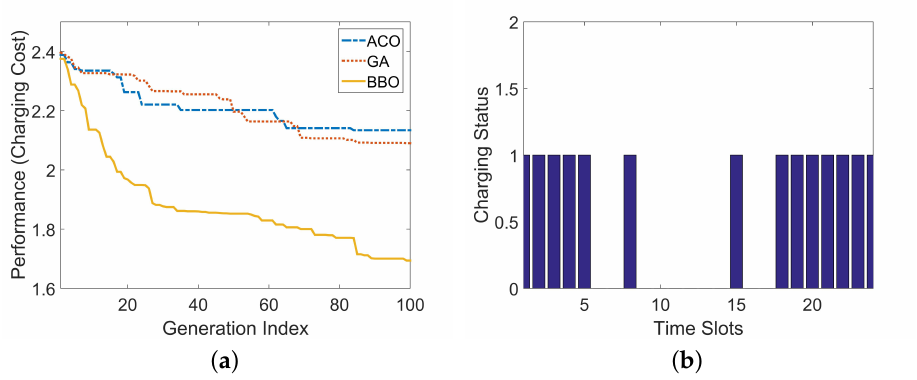
Figure 8. A charging schedule during 0:00–1:00 a.m. by heuristic algorithms. ( a ) Performance (charging cost) comparison for ACO, GA, and BBO in a single time slot and ( b ) a charging schedule by BBO at the time slot during 0:00–1:00 a.m. Table 2. Performance comparisons for algorithms GA, ACO, and BBO. “Best”, “Mean”, and “Worst” are the minimal cost, averaged cost, and maximal cost, respectively, in 25 runs for each algorithm. Charging Cost ( e Algorithm Names